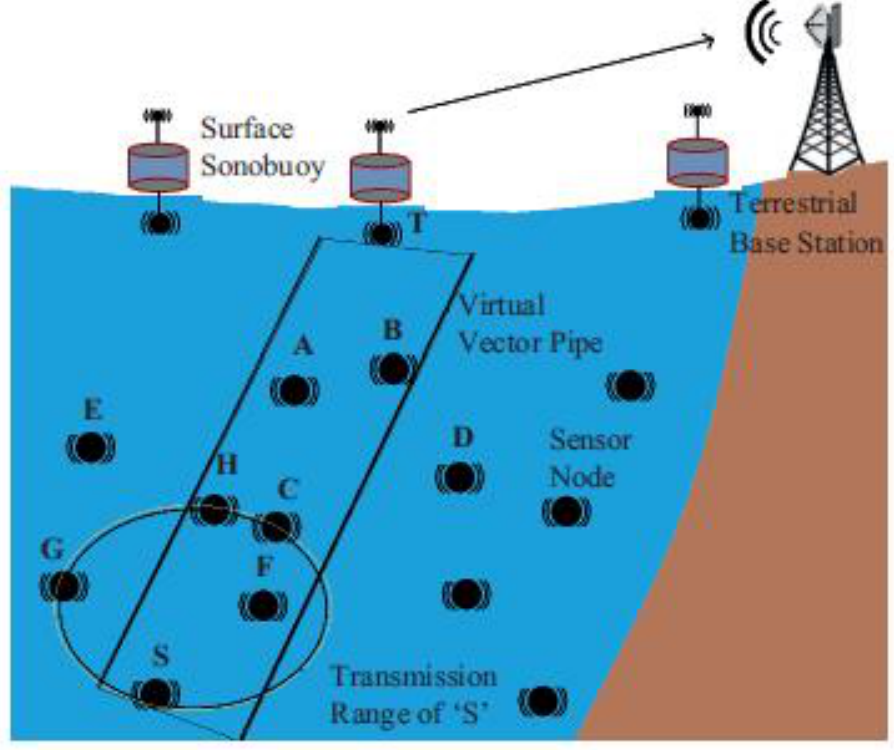
Figure 18. The best forwarder selection process in the SEEORVA protocol [58]. EEDOR-VA